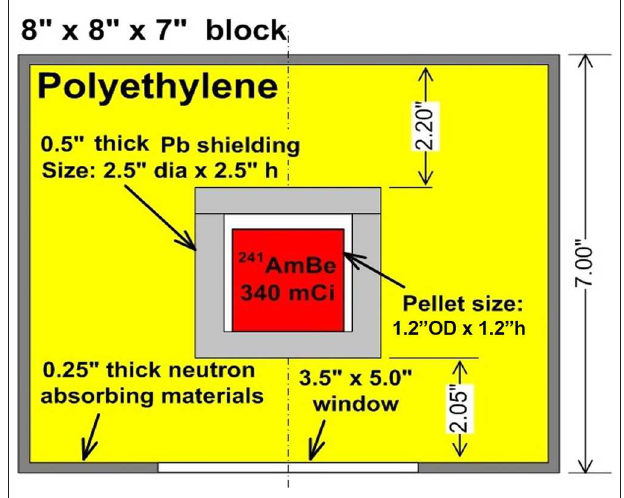
FIGURE 4 | The RMD custom designed casing for the 241 AmBe neutron source. The source holder geometry is designed in a way that most of the fast neutrons are thermalized by the polyethylene (as moderator) before reaching the detector. The “dia.” on the figure is the acronym for diameter.